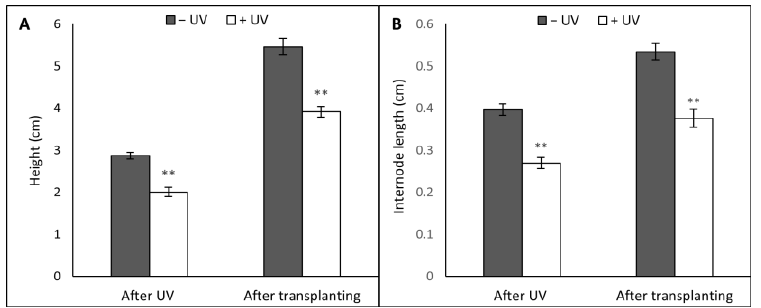
Figure 3. Parameters measured were the total number of leaves ( A ), the number of branches ( B ), the number of leaves on branches ( C ) and stem thickness (mm) ( D ) . Before the UV exposure stage, the mean of the total number of leaves was equal to 6, the number of branches and the number of leaves on branches was equal to 0, while the stem thickness was 0.558 mm. Asterisks indicate a significant difference between the UV treatments with p < 0.05 (*) or p ≤ 0.001 (**).